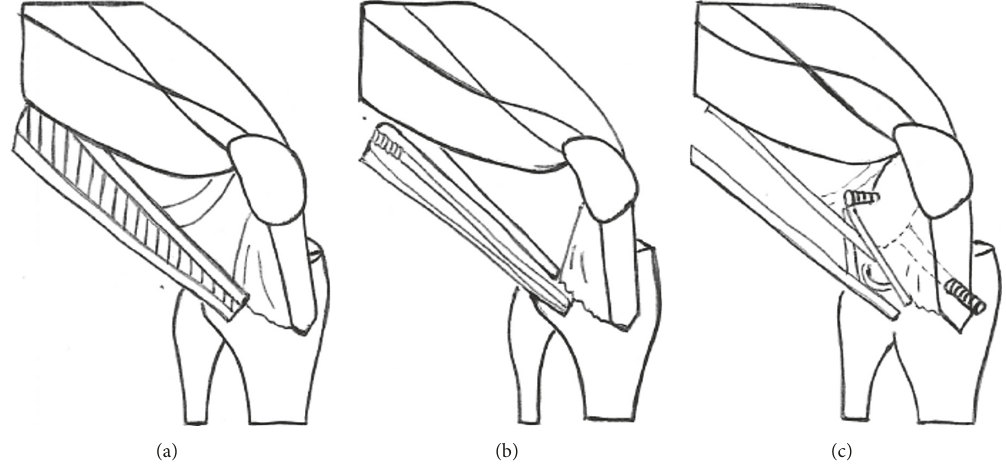
Figure 8: Modified MacIntosh procedure for ACL